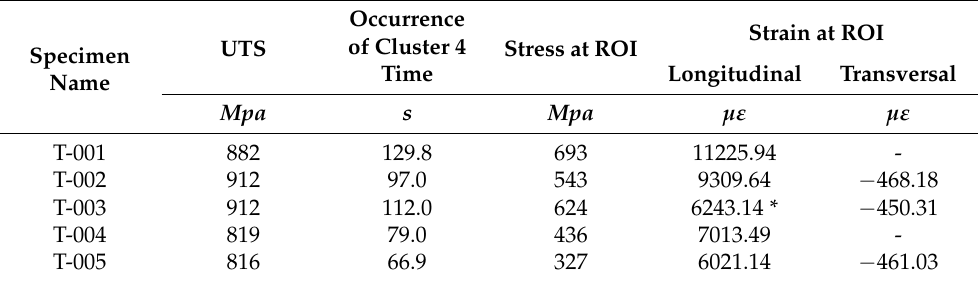
Table 4. Mechanical results at the region of interest (occurrence of Cluster 4